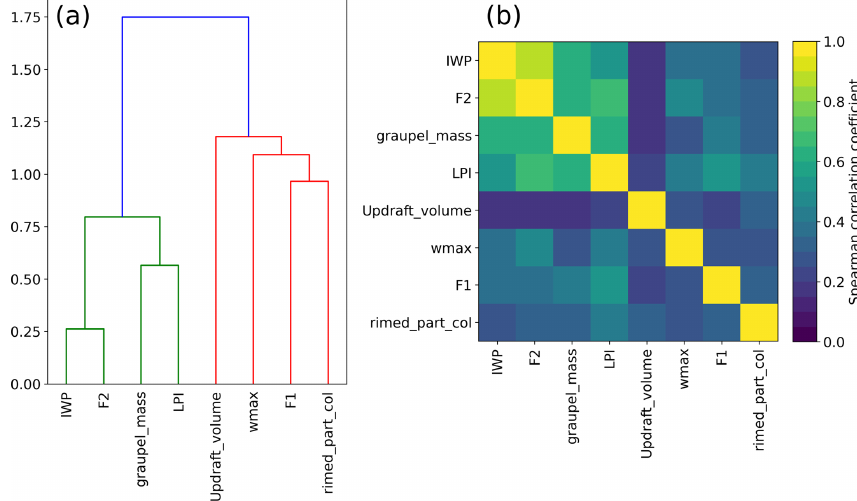
Figure 12. (a) Dendrogram of the Spearman rank-order correlations of the proxies and (b) correlation